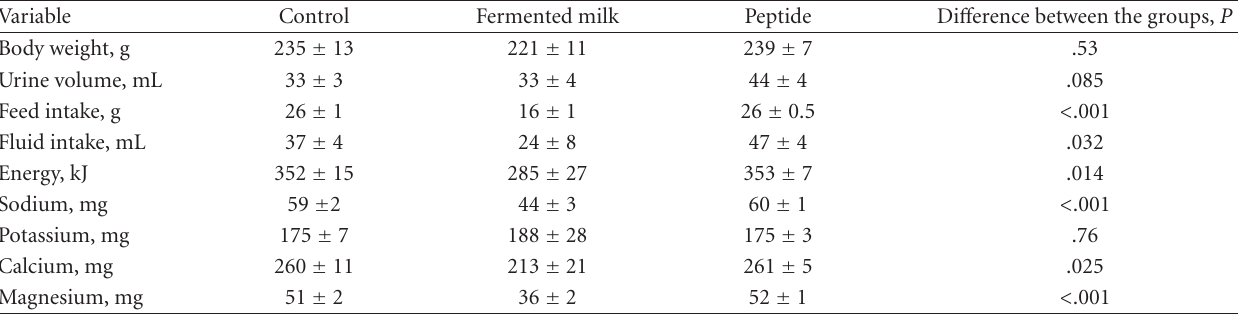
Table 1: Body weight, urine volume, and the intake of feed, fluids and minerals during the 24-hour period in metabolic cages at the end of the three-week treatment period (mean ± SE, n = 6 – 9).